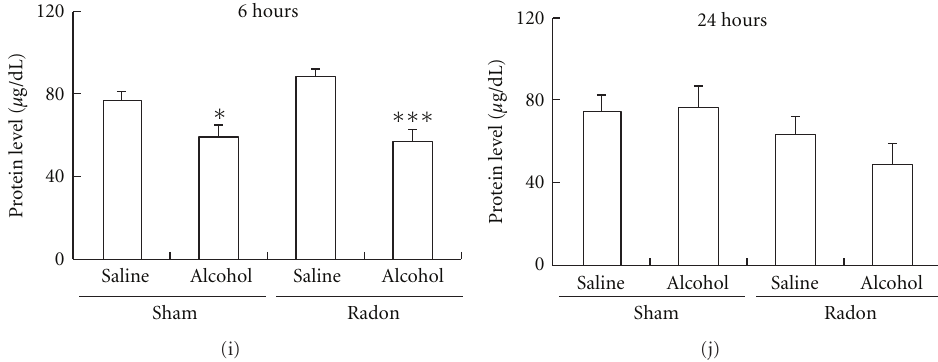
Figure 2: E ff ects of radon inhalation on hepatic function-associated parameters in the serum of alcohol-administrated mice. Each value indicates the mean ± SEM. The number of mice per experimental point is 4–6. ∗ P < 0 . 05, ∗∗ P < 0 . 01, ∗∗∗ P < 0 . 001 versus each saline administrated mice. # P < 0 . 05, ## P < 0 . 01 versus sham-inhaled and alcohol-administrated mice.